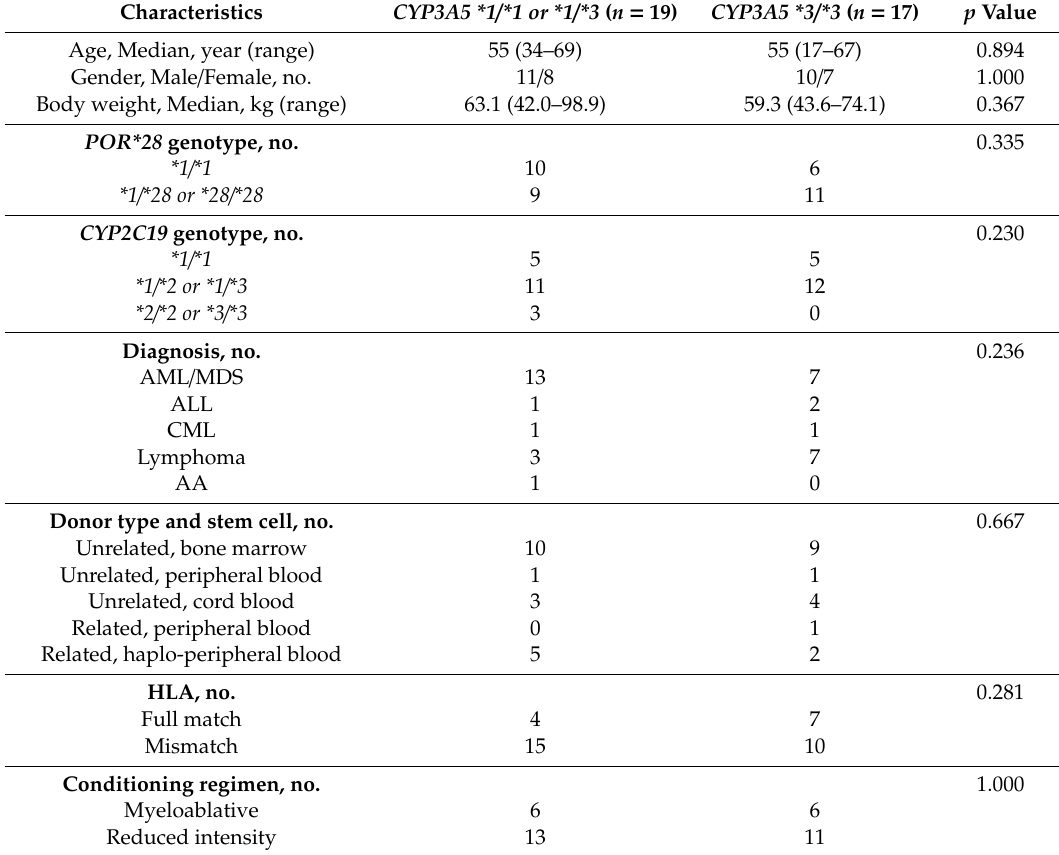
Table 1. Demographics of hematopoietic stem cell transplantation (HSCT) recipients according to CYP3A5 genotype ( n =